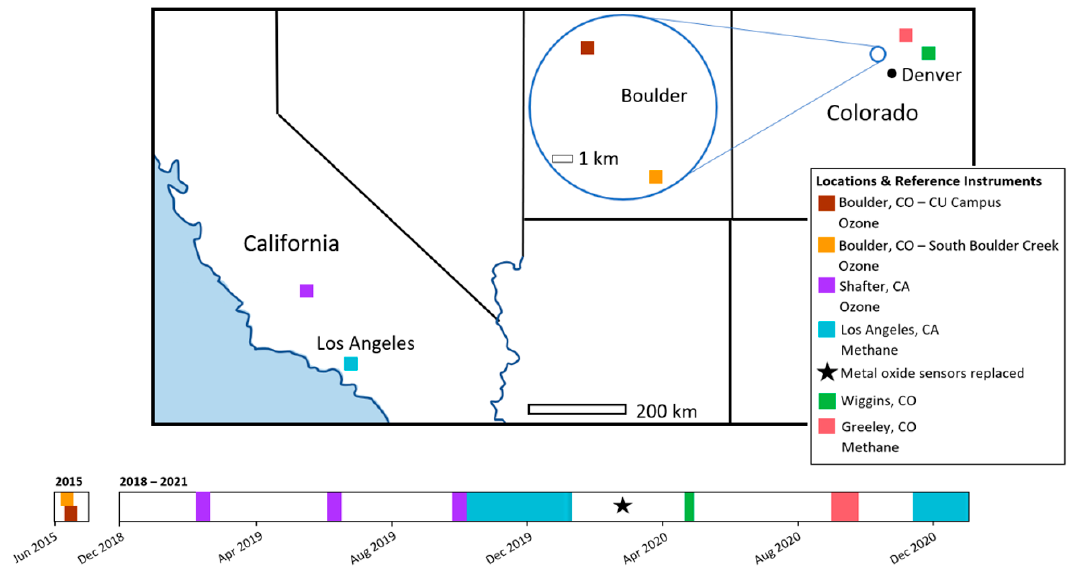
Figure 1. Map and timeline of co-locations for